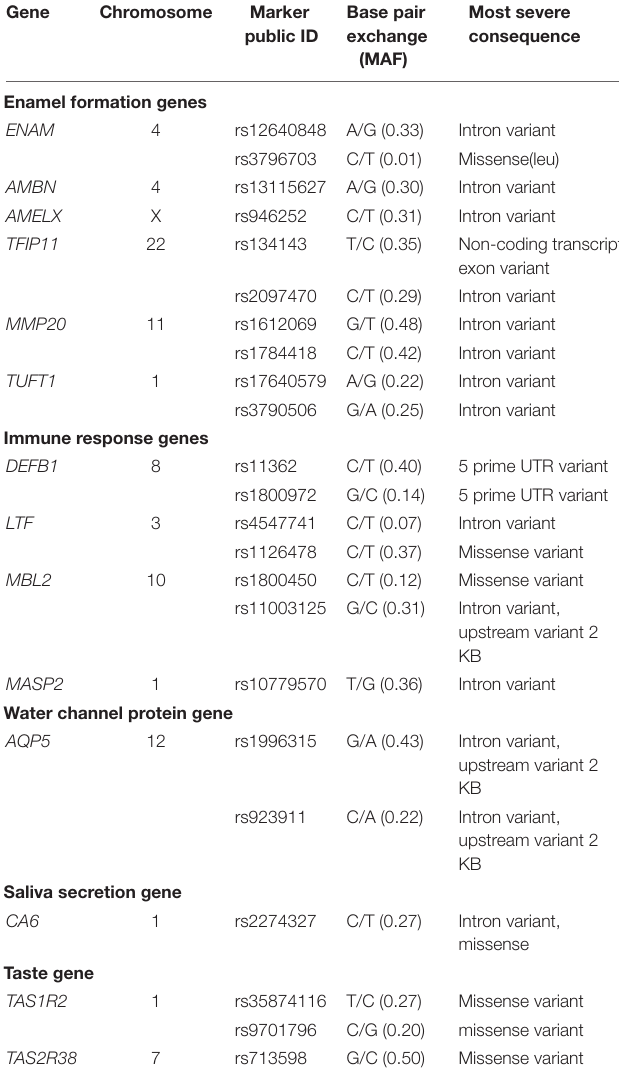
TABLE 1 | Candidate genetic markers evaluated in this